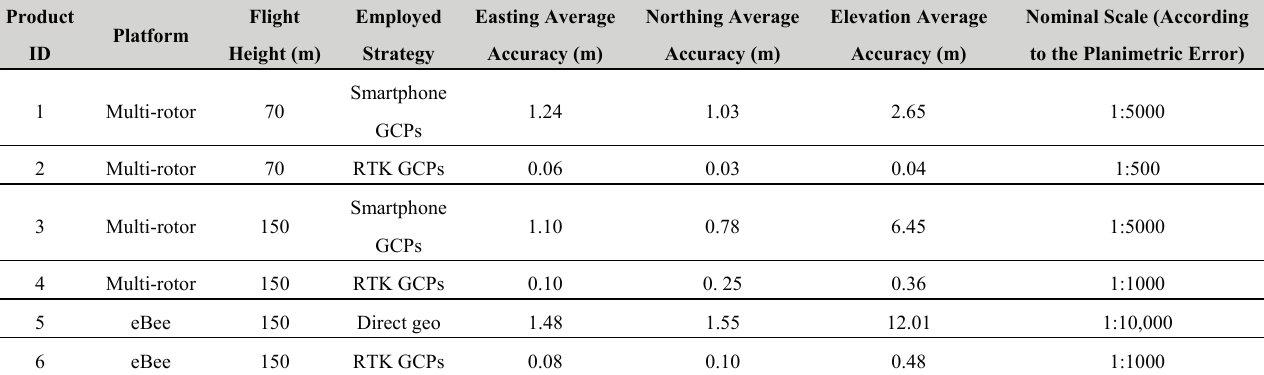
Table 7. Results of the accuracy assessment phase of the orthophoto